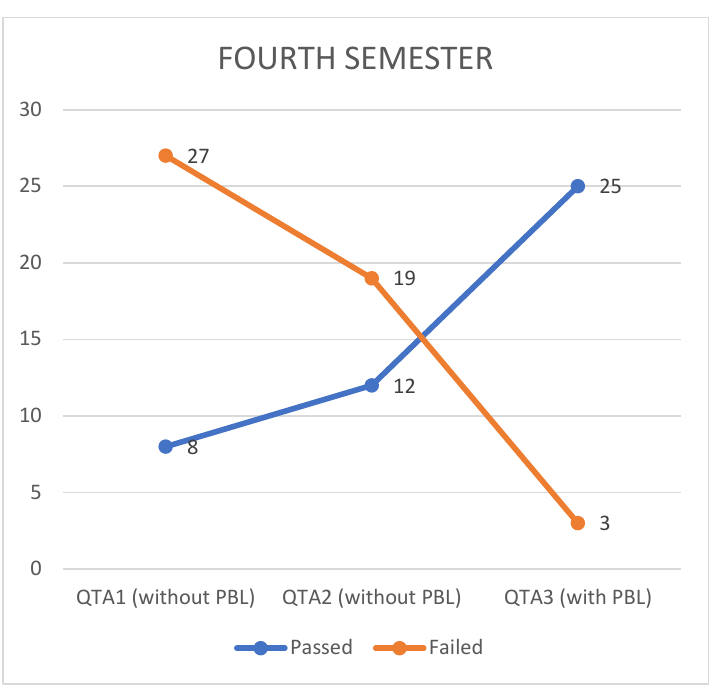
Fig. 8. Comparisons of PBL use in the fourth semester. Source: